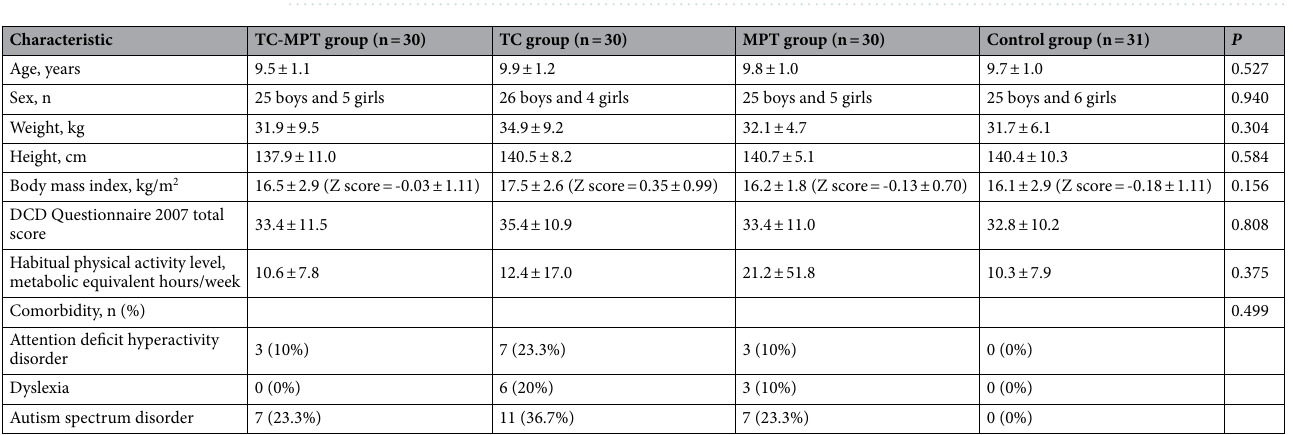
Table 1. Baseline characteristics of the participants. All values are means ± standard deviations unless specified otherwise. TC = tai chi, MPT = muscle power training, DCD = developmental coordination